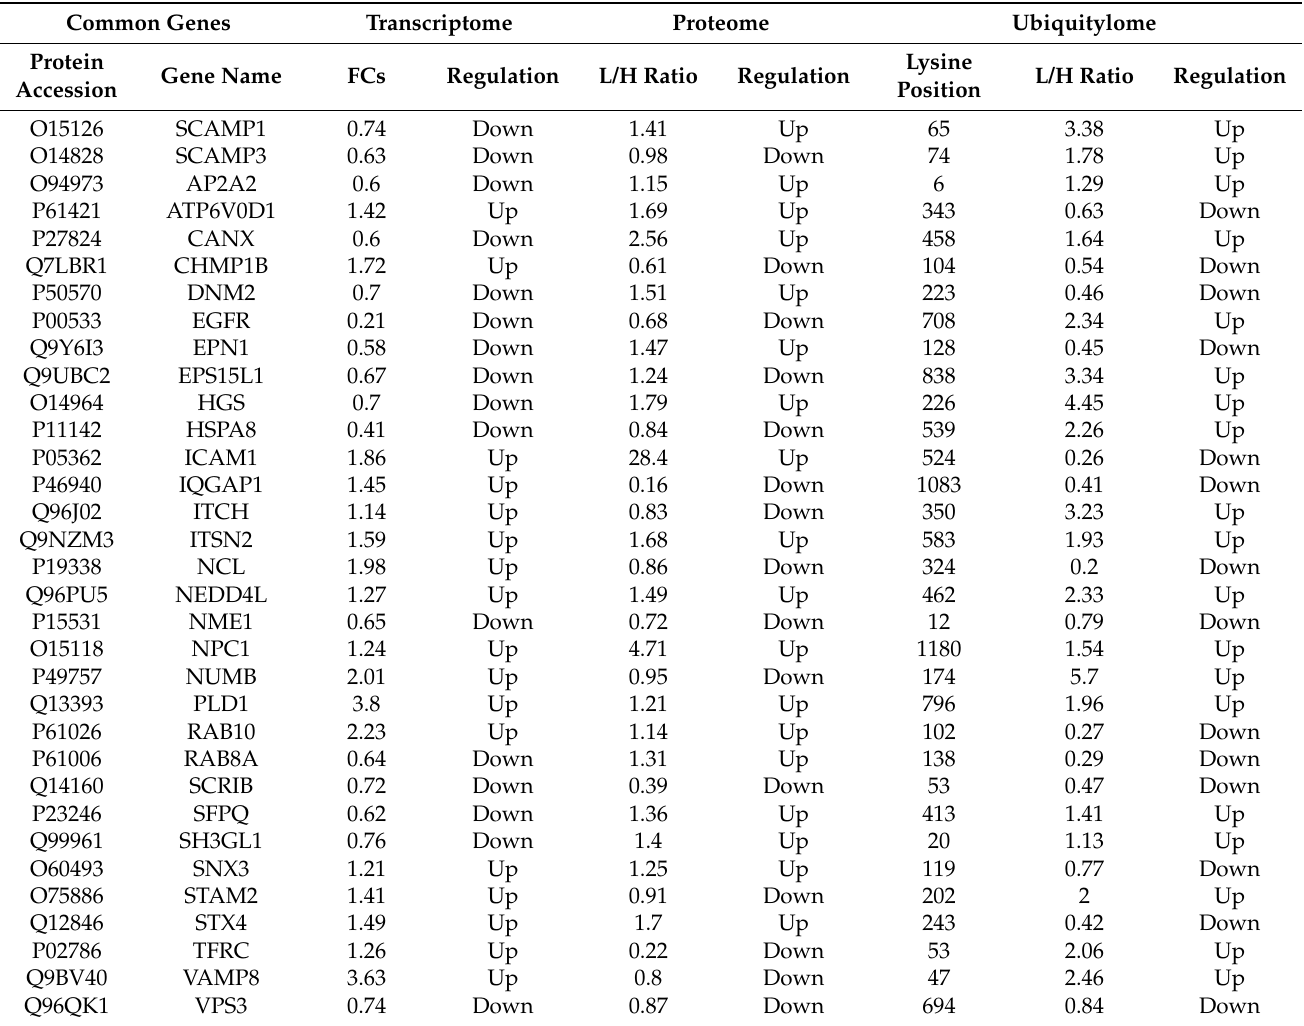
Table 2. Endocytosis associated differentially expressed common genes in the Transcriptome, Pro- teome, and Ubiquitylome in response to HBV